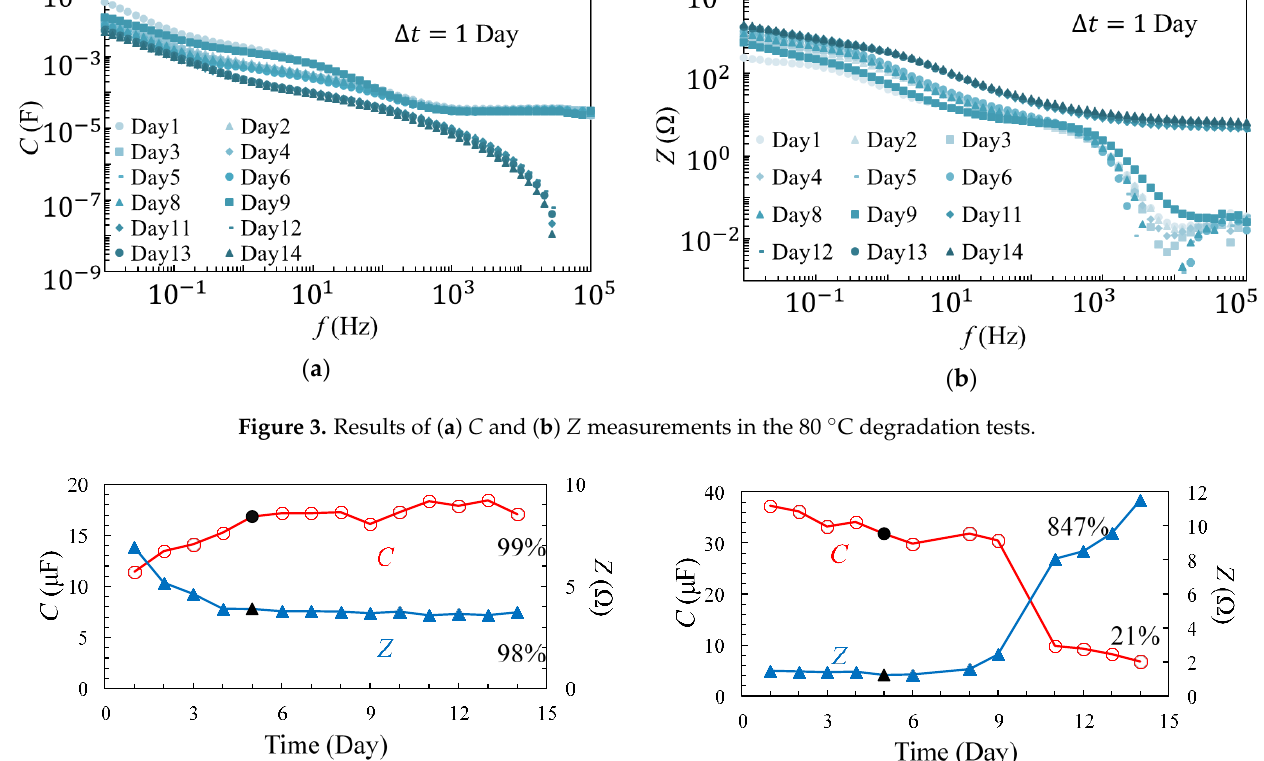
Figure 4. C and Z characteristics during ( a ) 25 °C and ( b ) 80 °C degradation tests at 1 kHz.